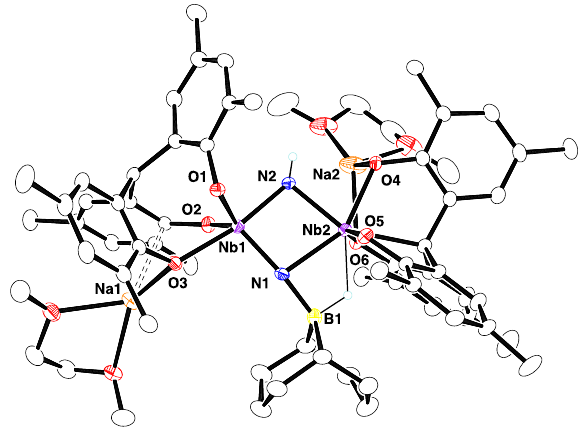
Figure 2. Molecular structure of 4 with thermal ellipsoids set at 30% probability level. All hydrogen atoms on carbon and methyl groups of tert -butyl groups are omitted for clarity.